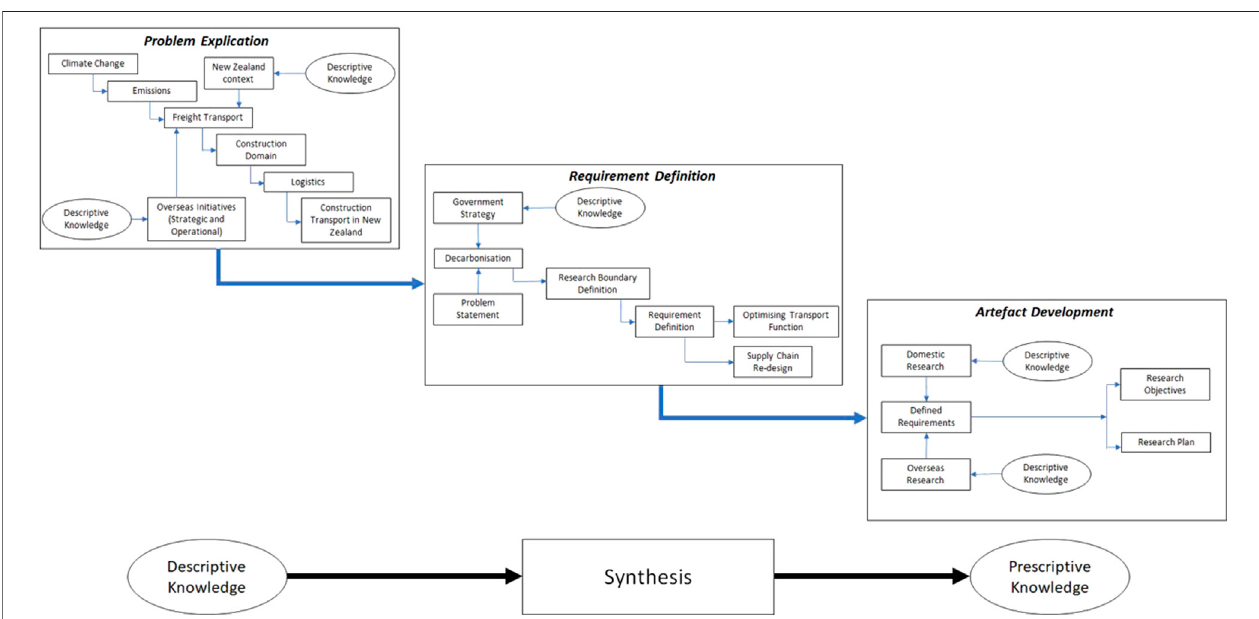
FIGURE 8 | The Research Framework development methodology (Authors ’ conception based on Johannesson and Perjons, 2014).